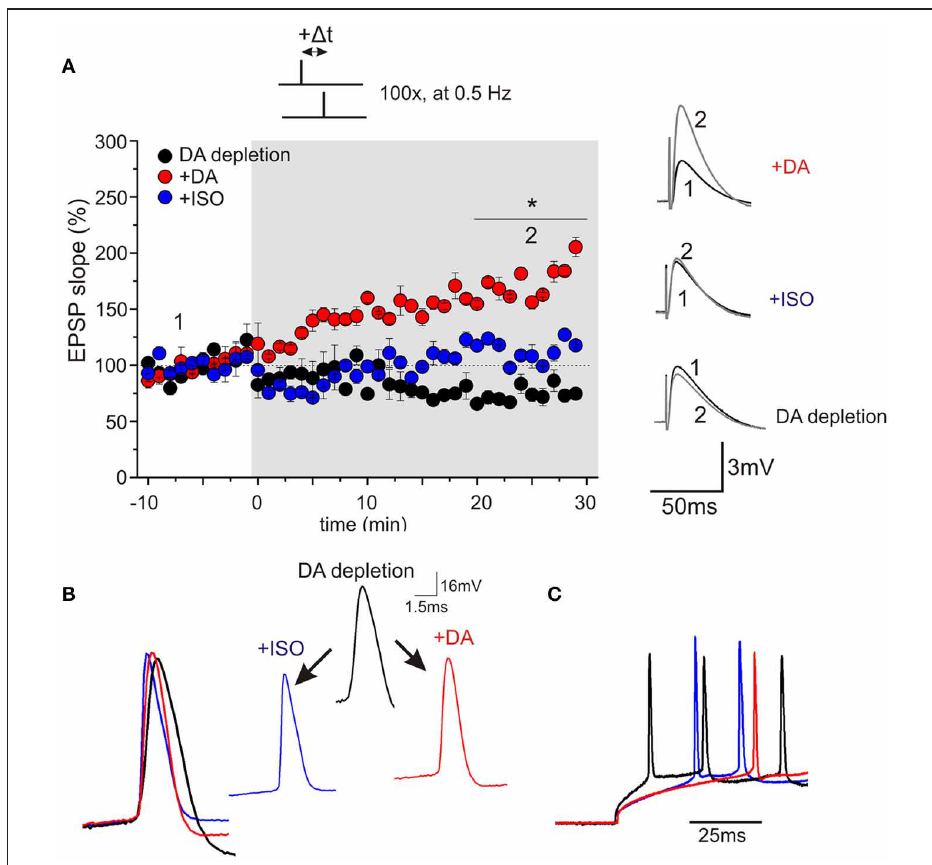
FIGURE 1 | Bath application of DA, but not ISO restores hippocampal spike-timing dependent plasticity in sucrose prepared slices. (A) Synaptic responses were recorded in the current clamp mode in CA1 pyramidal neurons of juvenile rats (P15–P20). Pre-stimulus membrane potential prior to recording was − 70mV for all cells. Presynaptic stimulation of Schaffer collaterals was performed every 20s (for graphs: data binned to 1min means). After recording of baseline for 10min, STDP was induced by a 1EPSP/1AP pairing (100 × , every 2s; at time point zero). Black symbols indicate neurons of the DA depleted group (DA depletion), red symbols indicate DA treated neurons ( + 20 μ M DA) and blue symbols show ISO treatment ( + 10 μ M ISO; * p < 0 . 05). Inset on the left side shows original traces before and after STDP induction for the three different conditions. (B) AP rise times for all three conditions. Rise time is significantly faster after application of the neuromodulators. (C) Modulation of spike latency by neuromodulators: latency to first spike for DA depletion (black), rescue by DA (red) and unsuccessful rescue by ISO